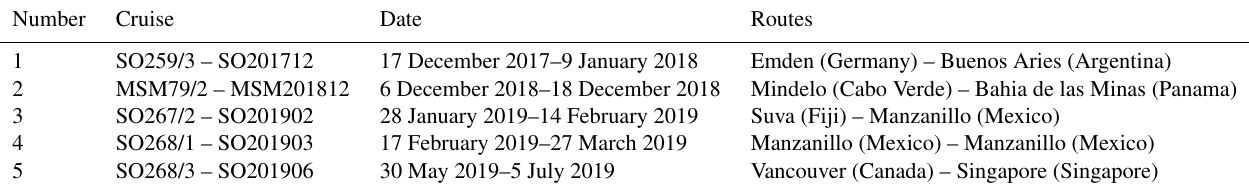
Table 1. List of RV Sonne (SO) and RV Maria S. Merian (MSM) cruises with MAX-DOAS measurements. Number Cruise Date